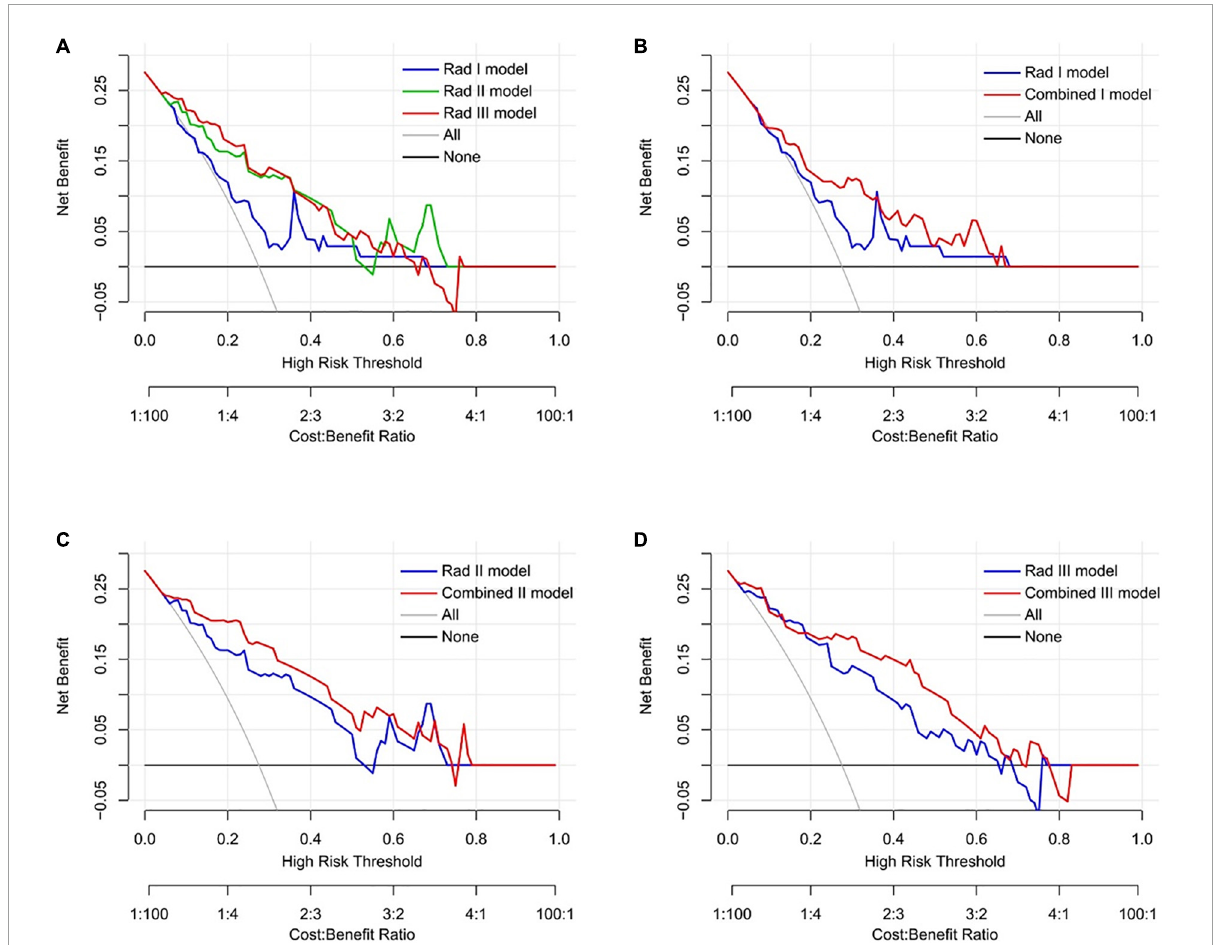
FIGURE8 Decision curve analysis of the predictive models in the validation dataset. (A) Comparison across three radiomic models. (B) Comparison between the Rad I model and the Combined I model (basal level). (C) Comparison between the Rad II model and the Combined II model (middle level). (D) Comparison between the Rad III model and the Combined III model (apical